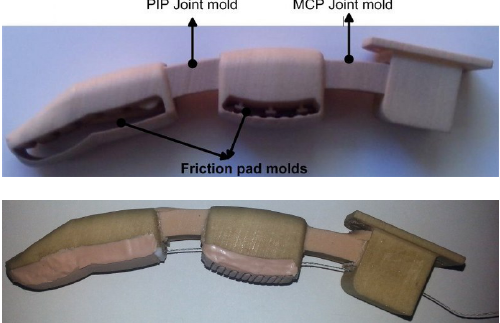
Figure 4. First fabrication methods: The 3D printed index finger before casting the Urethane rubber ( up ); the finger after casting ( down